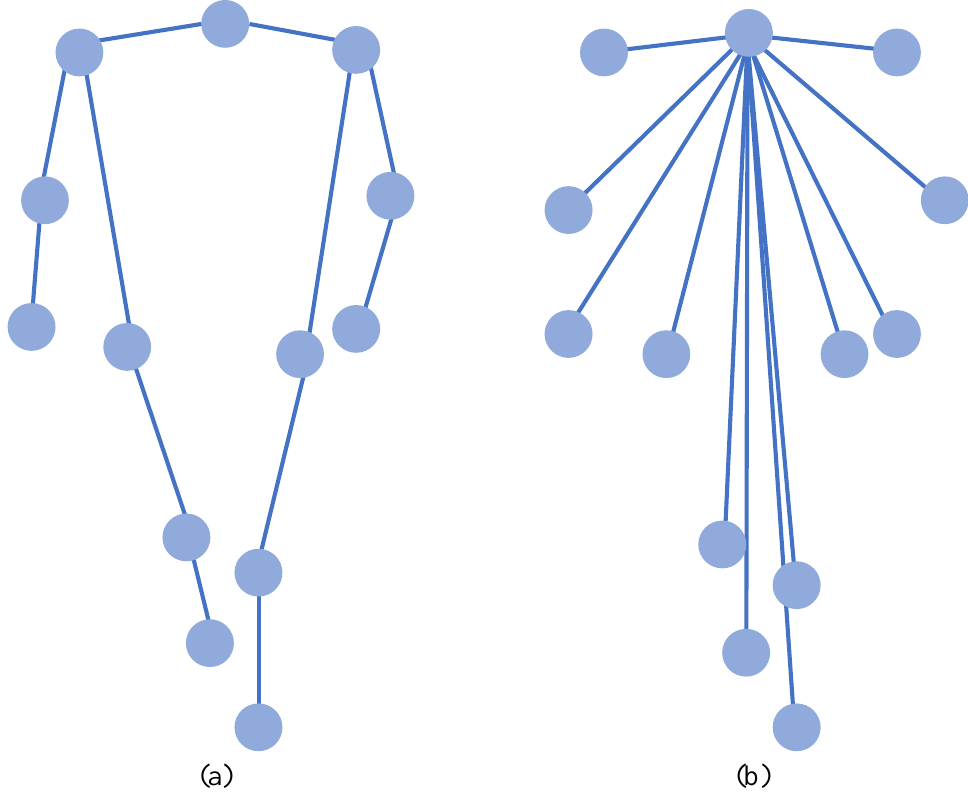
Figure 4. Joint connections (with head removed). ( a ) Local connections, ( b ) global